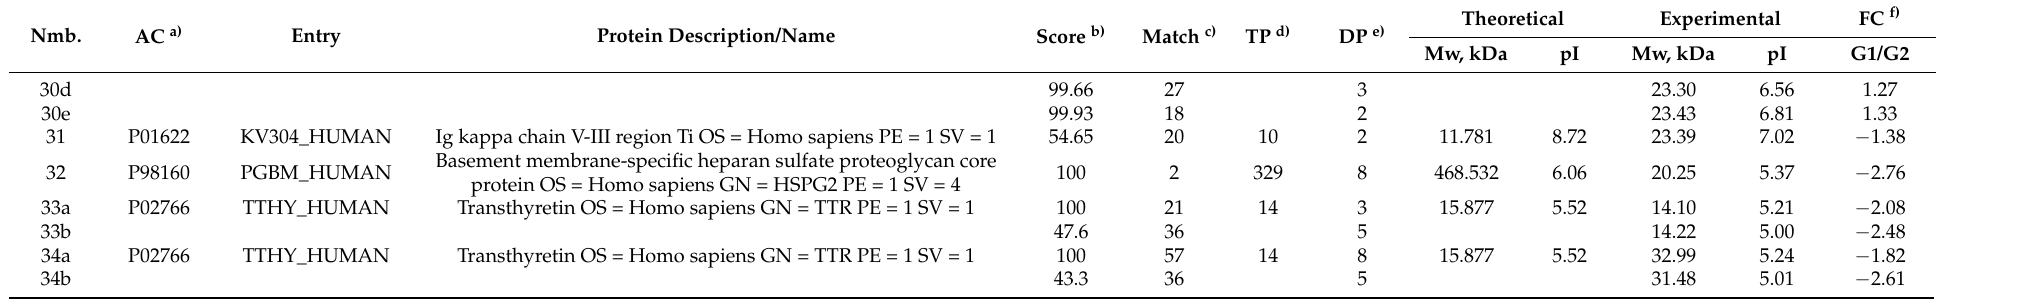
Table 2. The summarized search results (by UniProt, Expasy) of proteins identified from 2DE gels representing protein maps of amniotic fluid of